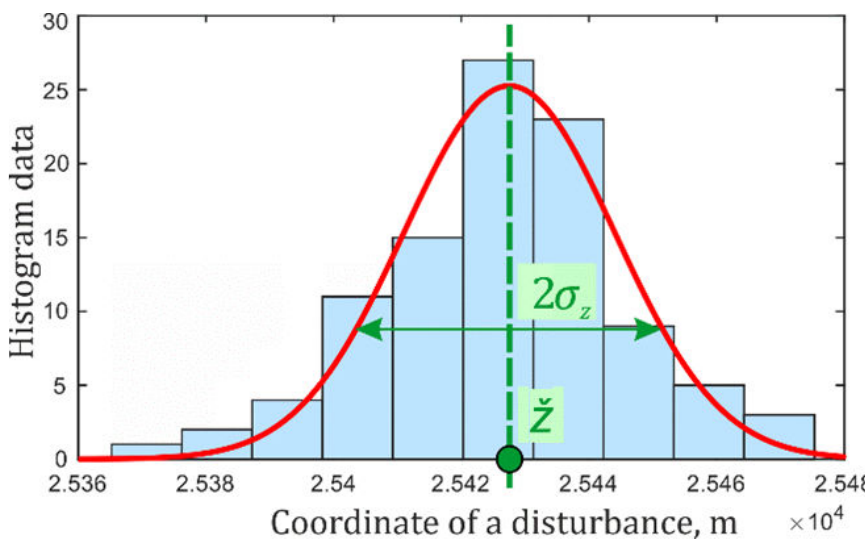
Figure 16. Coordinate determination histogram at ν D = 25 MHz.